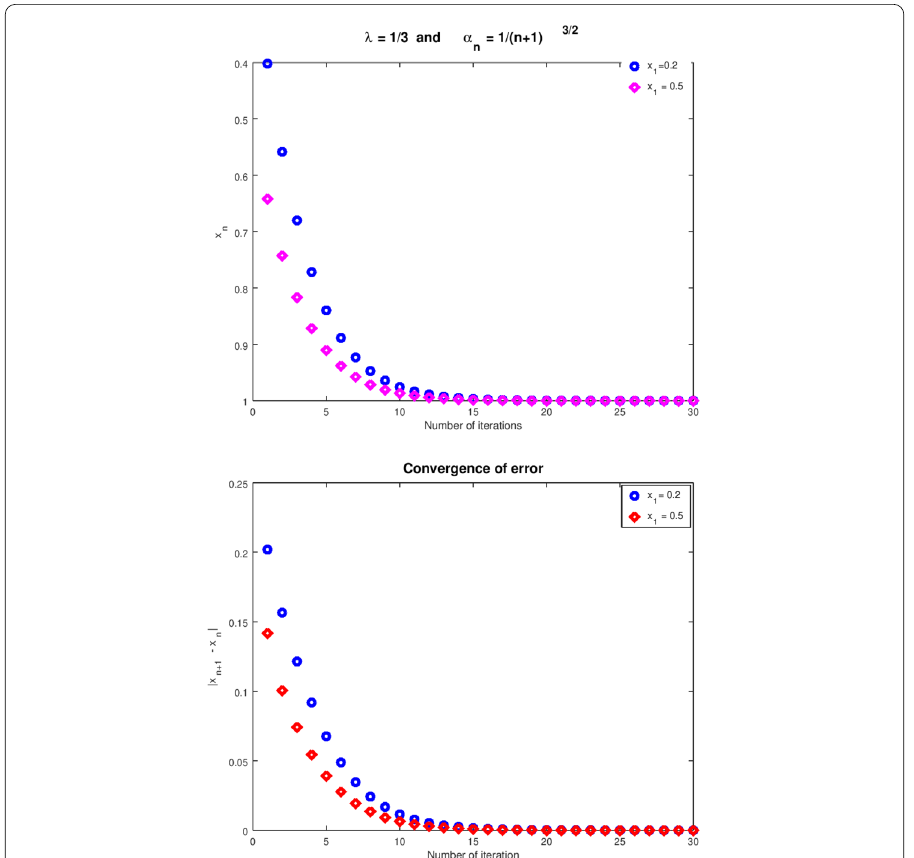
Figure 2 Computational convergence of Algorithm 1 and error term | u n +1 – u n | with the choices of scalars λ = 1 and α n = 1 and different initial points u 1 = 0.2, u 1 = 3 ( n +1)3/2